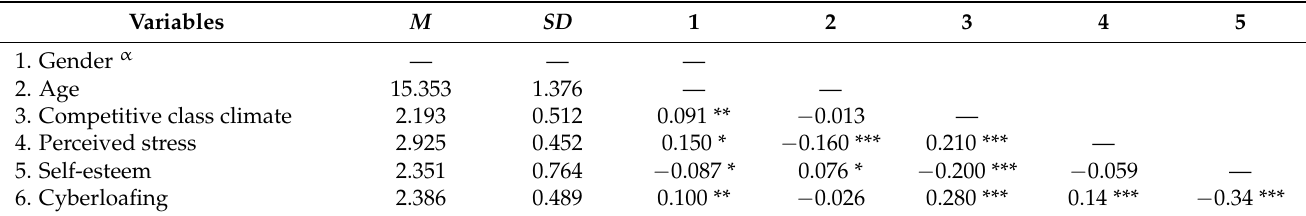
Table 1. Mean, standard deviation, and correlation coefficients.